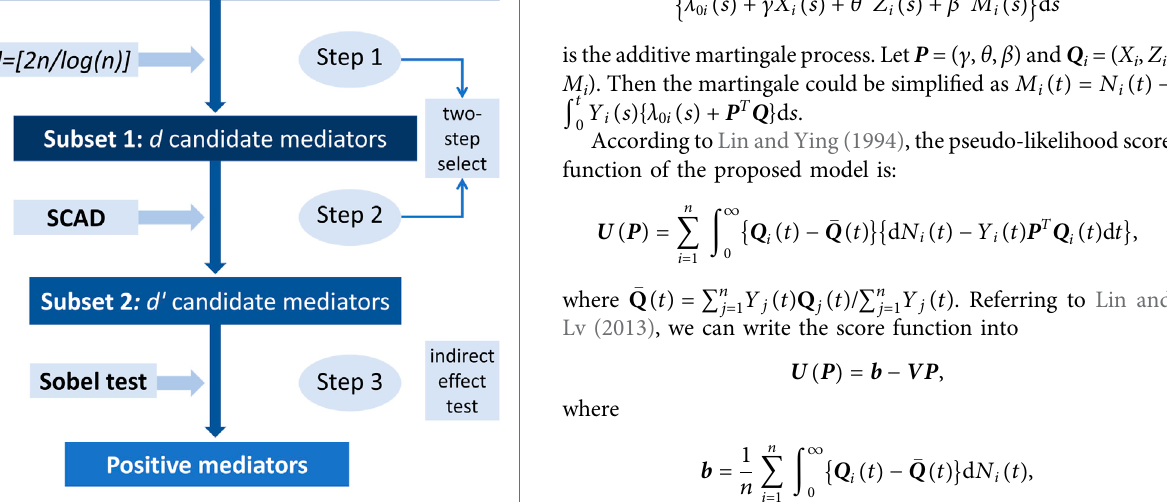
FIGURE 2 | Overall work fl ow of the proposed